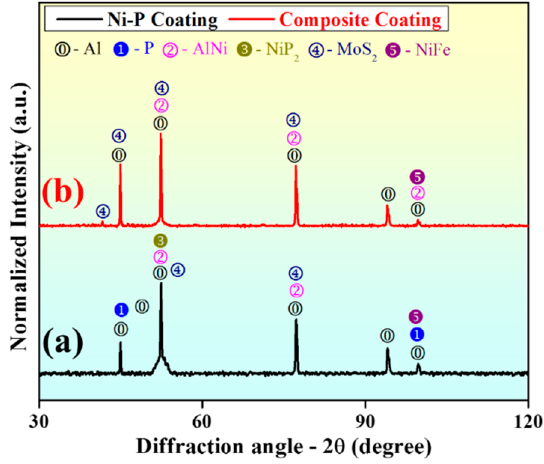
Figure 9. XRD plots of ( a ) Ni-P coating and ( b ) composite coating with 3g/L Al 2 O 3 and 1 g/L MoS 2 powder content.